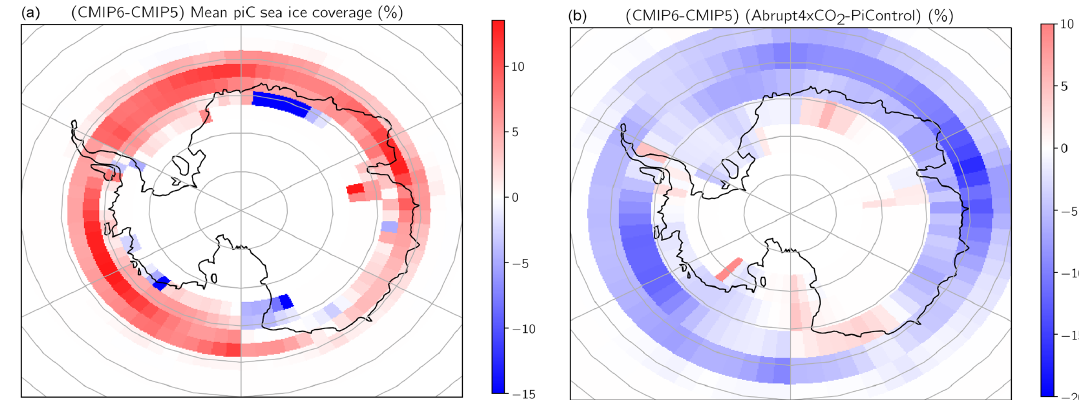
Figure 9. (a) Map of the difference in mean piControl sea ice abundance climatology between CMIP6 and CMIP5 in the Antarctic and (b) of the difference between CMIP6 and CMIP5 in the reduction of sea ice abundance in abrupt4xCO2 . Reduction in sea ice for each CMIP ensemble calculated as difference in sea ice coverage between the average piControl simulation (over the 150 years corresponding to abrupt4xCO2 ) and the mean of the last 30 years of the abrupt4xCO2 simulation. Averaged on a 5 ◦ by 5 ◦ grid.